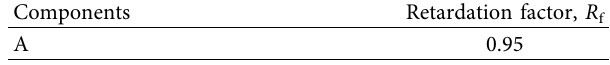
Table 7: Chromatographic separation of fraction A collected using hexane as the mobile